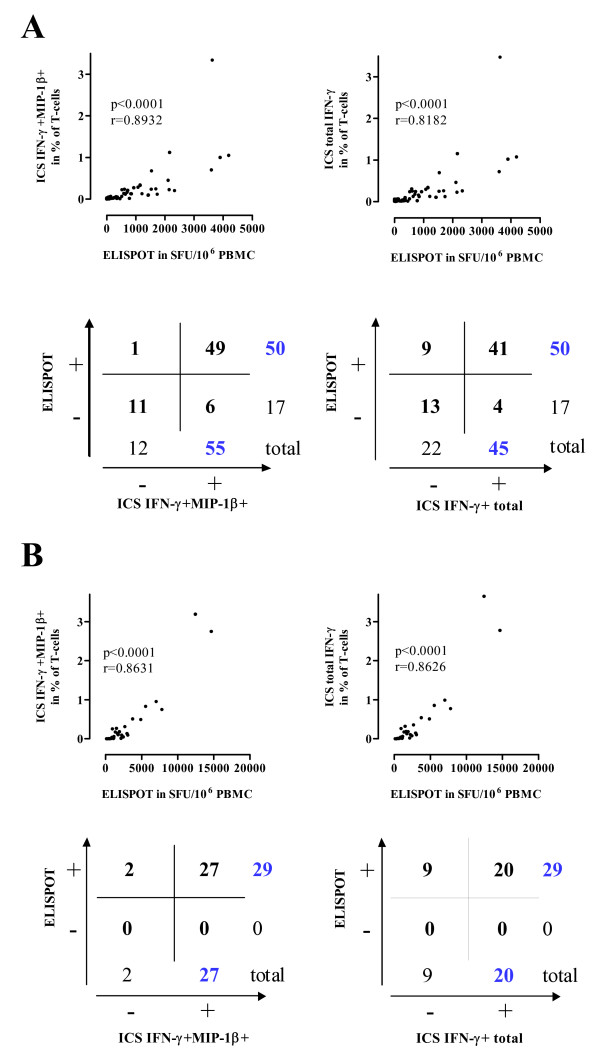
Comparison between the ICS and two independently performed ELISPOT assays. The two ICS data evaluation systems are compared with ELISPOT assays performed by laboratory 1 (A) and laboratory 2 (B). Correlations between frequencies of responding T-cells detected by ELISPOT and by ICS using the IFN-γ+ MIP-1β+ or the total IFN-γ+ data evaluation system are determined by Spearman's rank correlation. r and p values are shown in each graph. 2 × 2 contingency tables comparing the positive T-cell responses detected by ELISPOT and by ICS with the two data evaluation systems are also shown.